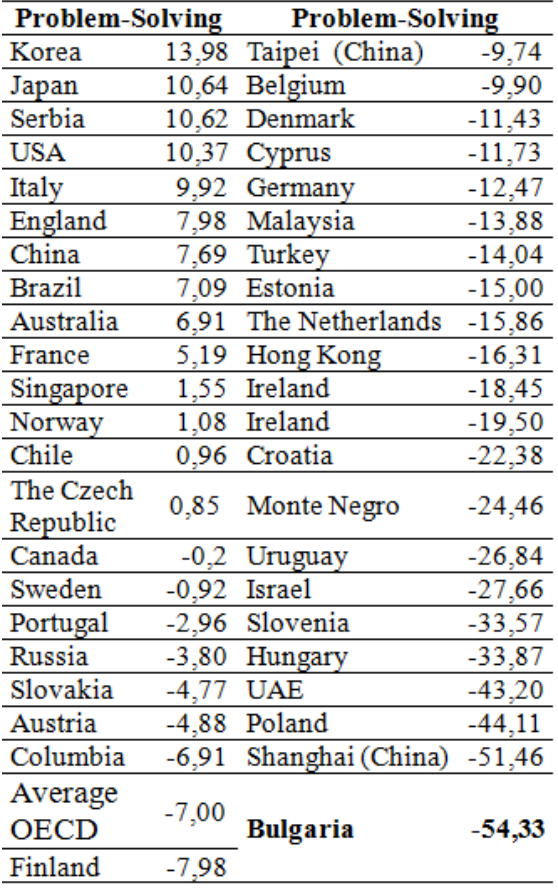
Table 1. Results in solving real-life problems PISA